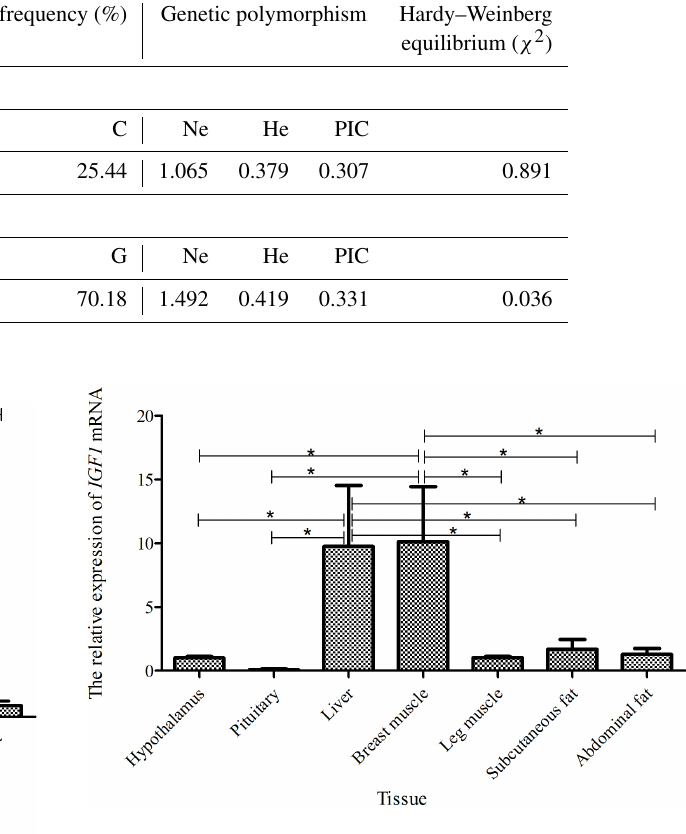
Figure 5. The mRNA expression of the IGF1 gene in different tis- sues of a 15-week-old Shitou